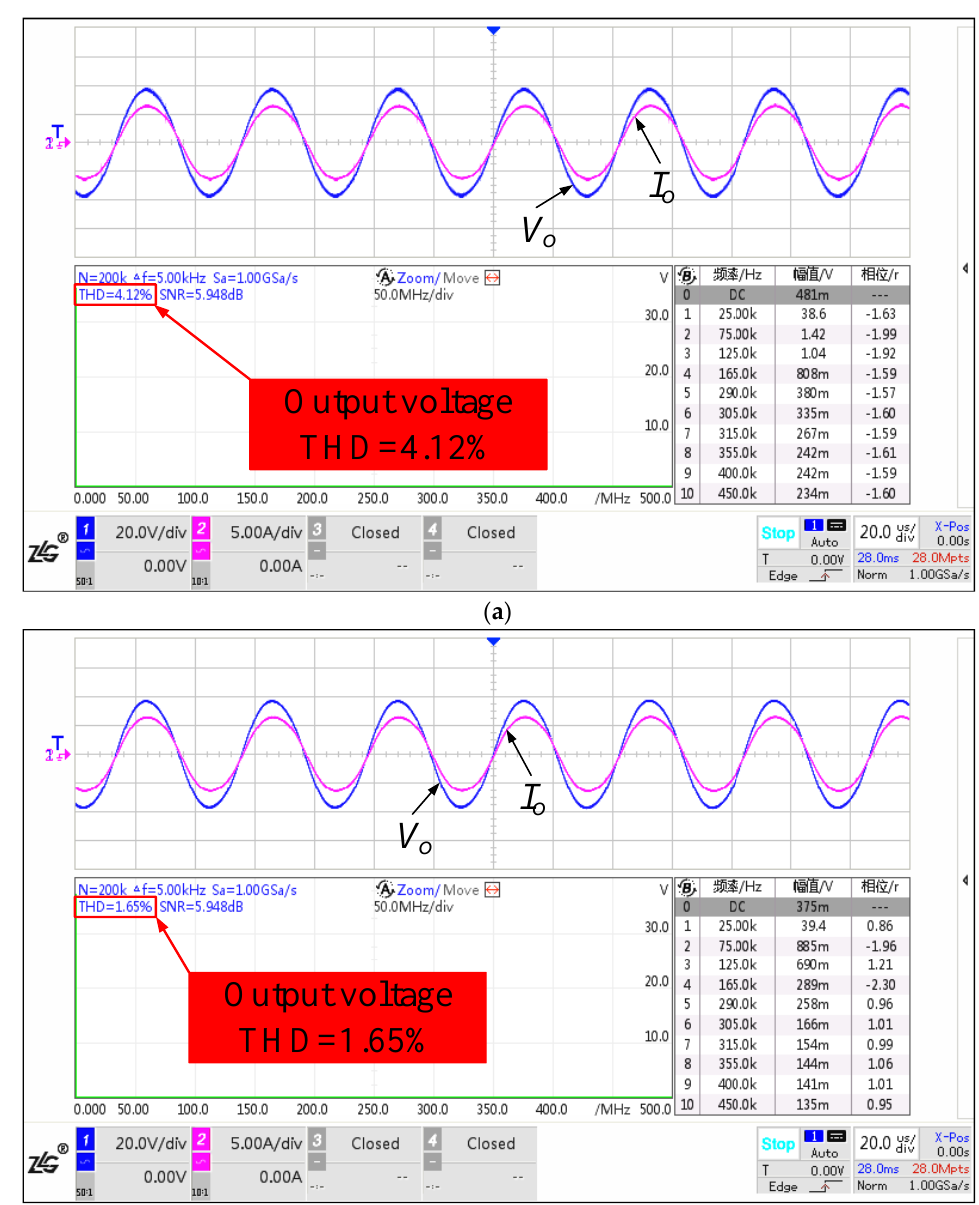
Figure 17. The THD comparison of steady state outputs: ( a ) with PI controller; ( b ) with PIR controller.